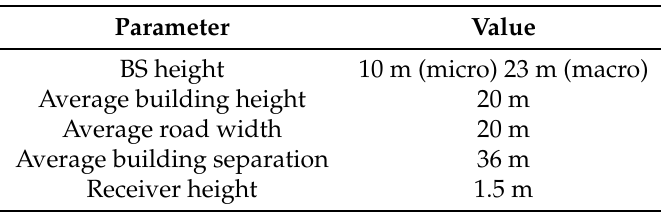
Table 5. Parameters for the walfisch-ikegami